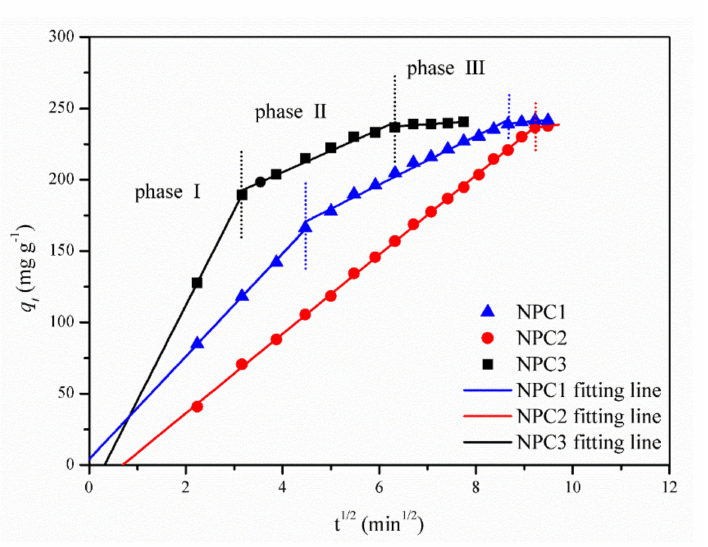
Figure 7. Plots of intra-particle diffusion model fitting curves for the adsorption behavior of catalysts in MO